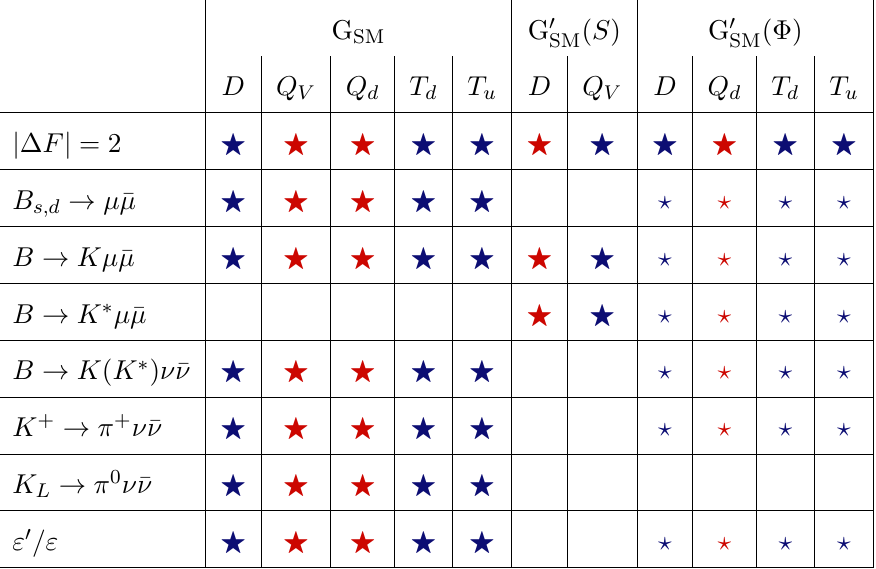
(cid:1) F = 1 decays in G 0 ((cid:8)) models. SM j j